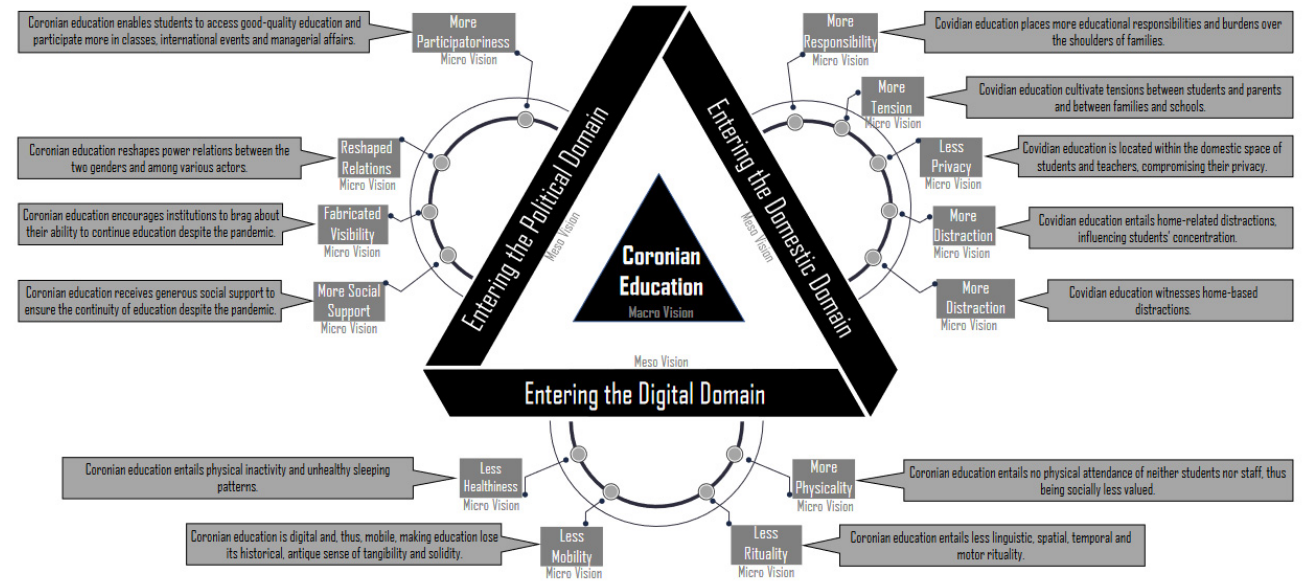
Figure 1. Data Collection and